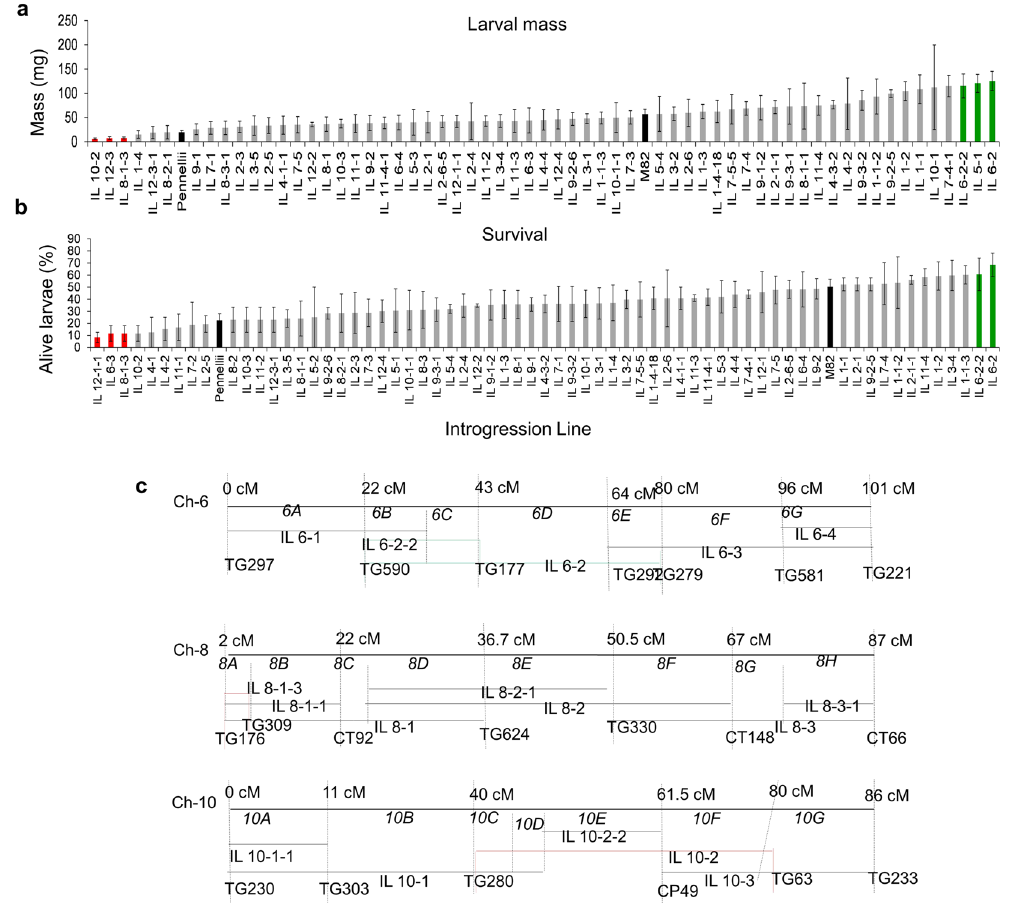
Figure 2. Colorado potato beetle performance on S. pennellii introgression lines. ( a ) CPB larval mass and ( b ) survivorship were recorded 10 days after infestation. Black bars show performance and survival on parental lines. Green bars represent introgression lines where CPB has either significantly better performance than on M82 or greater survival than on S. pennellii (P < 0.05, Dunnett ’ s test). Red bars represent introgression lines where CPB has the same performance or survivorship as on S. pennellii plants and lower than on M82 (P < 0.05, Dunnett ’ s test). All bars represent the mean of 2 or 3 plants. ( c ) Representation of the chromosomes with introgression lines that affect CPB resistance. Each chromosome is divided into bins based on the classic tomato genetic map (marked with italics, 6 A, 6B , etc.) Horizontal bars are marked with the name of the respective introgression lines carrying segments of S. pennellii introgressed into S. lycopersicum . The approximate position of the flanking markers is shown in centimorgans (Tomato Expen 2000 map, www.solgenomics.net). The most susceptible (IL 6-2, IL 6-2-2, green) and the most resistant (IL 8-1-3, IL 10-2; red) lines are indicated by colored